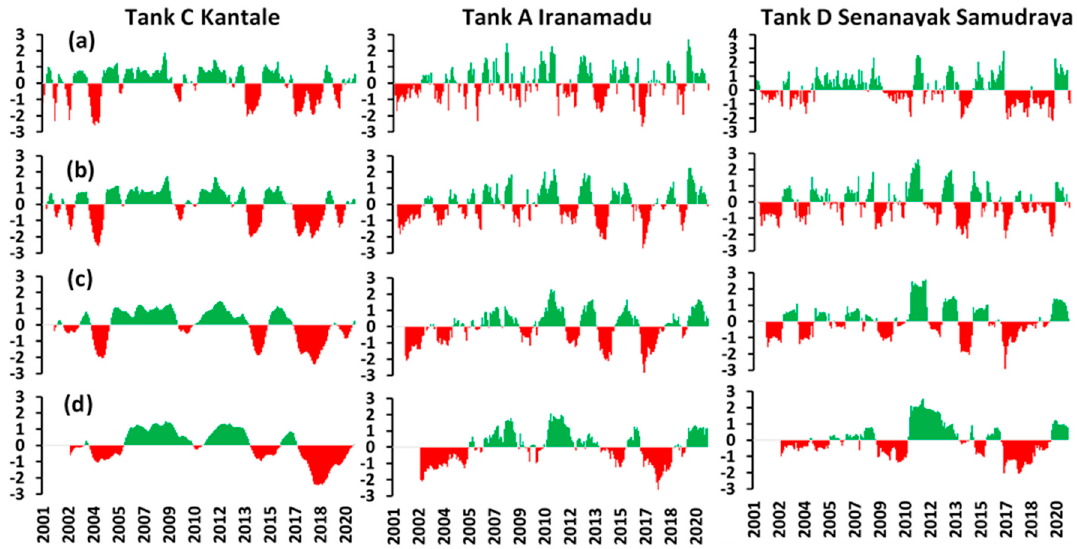
Figure 9. Standardized Precipitation Index (SPI) calculated for different time frames. ( a ) 3, ( b ) 6, ( c ) 12, and ( d ) 24 months for the period of 2001 to 2020 for Tank C, Tank A, and Tank D. Green bars mark positive and red bars mark negative SPI values.